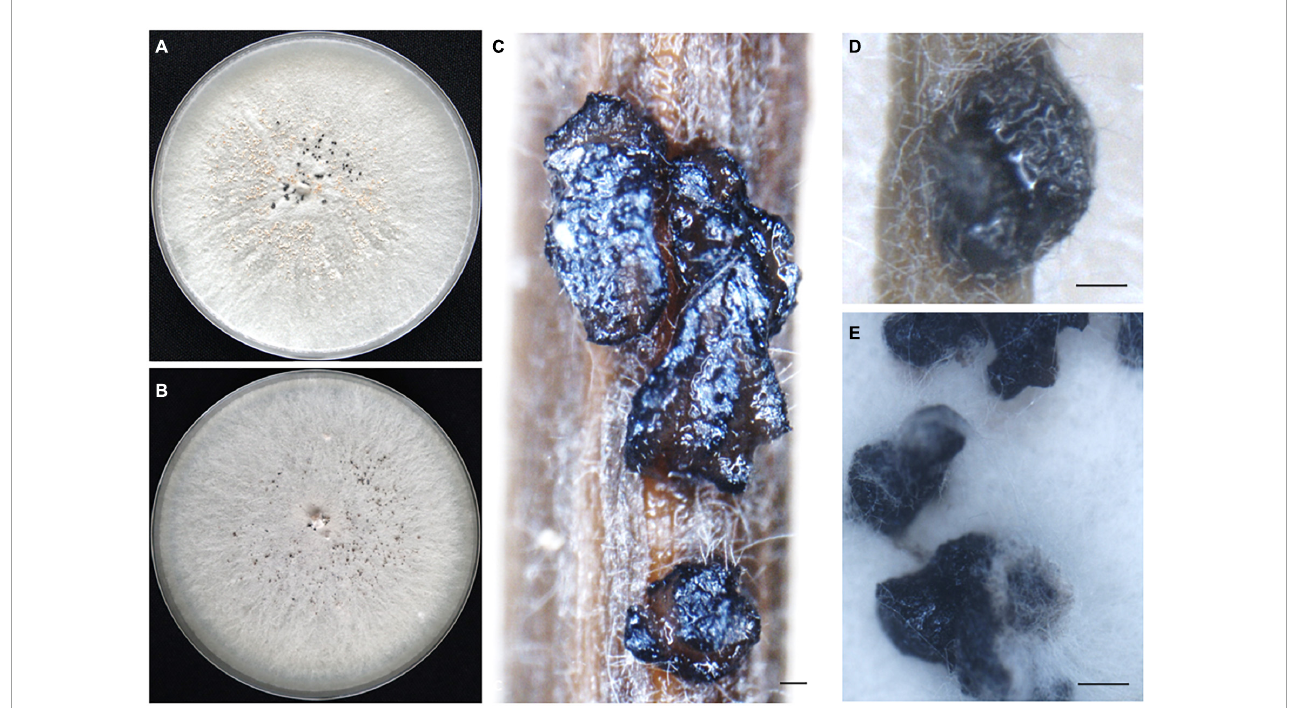
FIGURE3 Morphological characteristics of Diaporthe iberica . Front view of colony appearance on potato dextrose agar (PDA) (A) and malt extract agar (MEA) (B) ; sterile stromata on pine needle (C) and F. pruinosa leaf (D) and on the surface of PDA (E) ; Scale bar: panels (C–E) = 100 µ